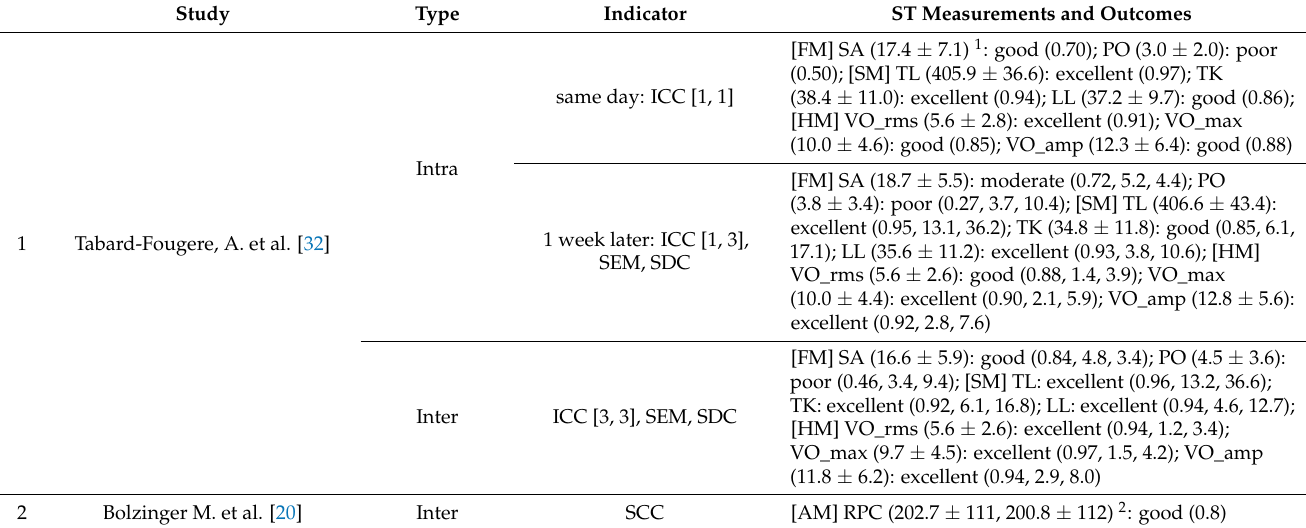
Table 6. Reliability